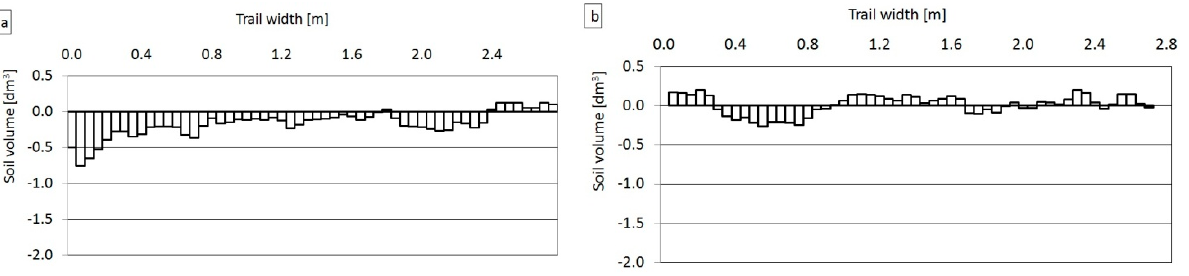
Figure 9. Changes in soil volume on trail sections before and after skidding: ( a ) Ht129U and ( b ) Ht129L.